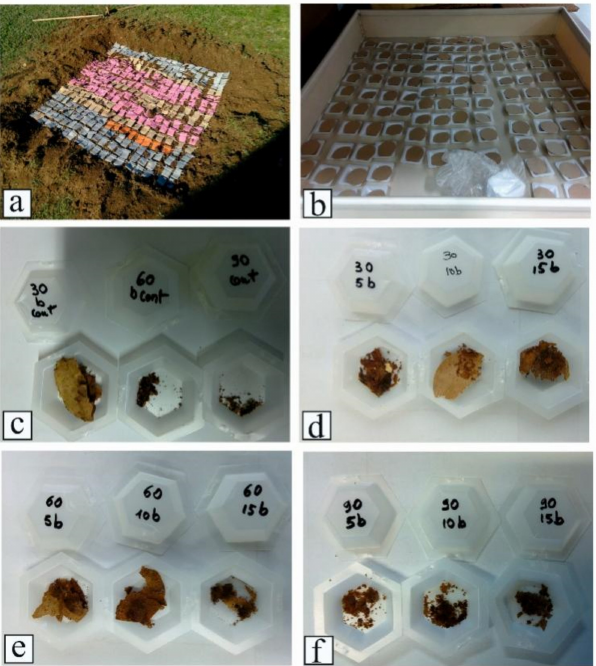
Figure 9. Soil burial degradation of ( a ) visual appearance of samples prior to field testing; ( b ) control samples use for field study; ( c ) 100% kraft pulp biocomposite samples after 30, 60, and 90 days; ( d ) 50%-50% 140 ◦ C, 150 ◦ C, and 160 ◦ C hydrolyzed wool and kraft pulp biocomposite samples after 30 days; ( e ) 50%-50% 140 ◦ C, 150 ◦ C, and 160 ◦ C hydrolyzed wool and kraft pulp biocomposite sample after 60 days; ( f ) 50%-50% 140 ◦ C, 150 ◦ C, and 160 ◦ C hydrolyzed wool and kraft pulp biocomposite sample after 90 days of soil burial